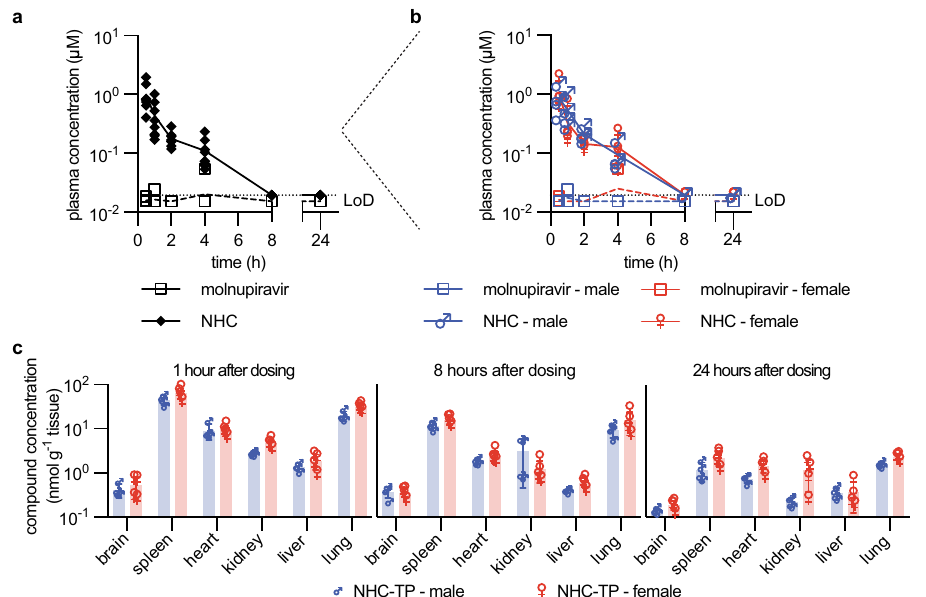
Fig. 5 | Single oral dose PK properties of molnupiravir in Roborovski dwarf hamsters. Male and female dwarf hamsters were gavaged with molnupiravir at (250mg/kg body weight). a Plasma concentrations of molnupiravir and NHC, determined over a 24-hour period after dosing. b Plasma concentrations from a , showing male and female subgroups; LoD level of detection (0.0193 μ M for